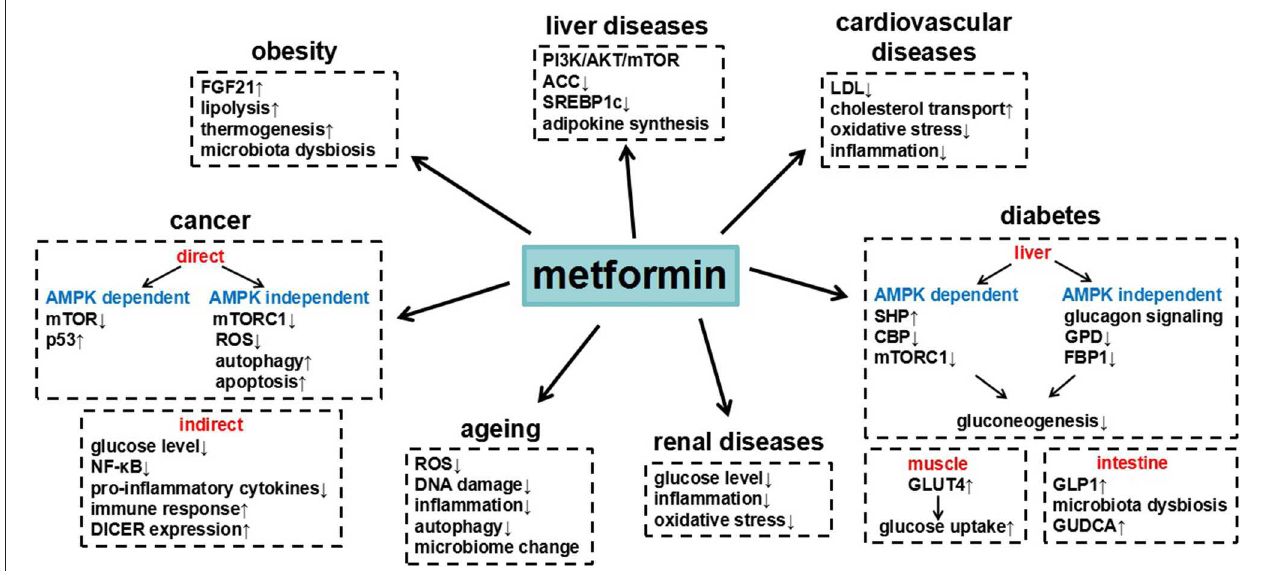
FIGURE 1 | Summary of metformin in different diseases and the underlying major